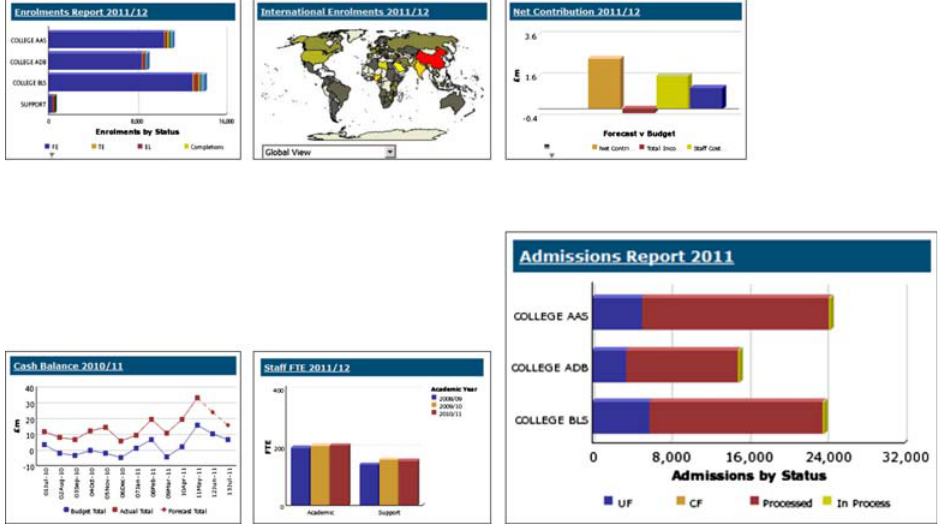
Figure 5. NTU ‘dashboard’ with admissions report shown